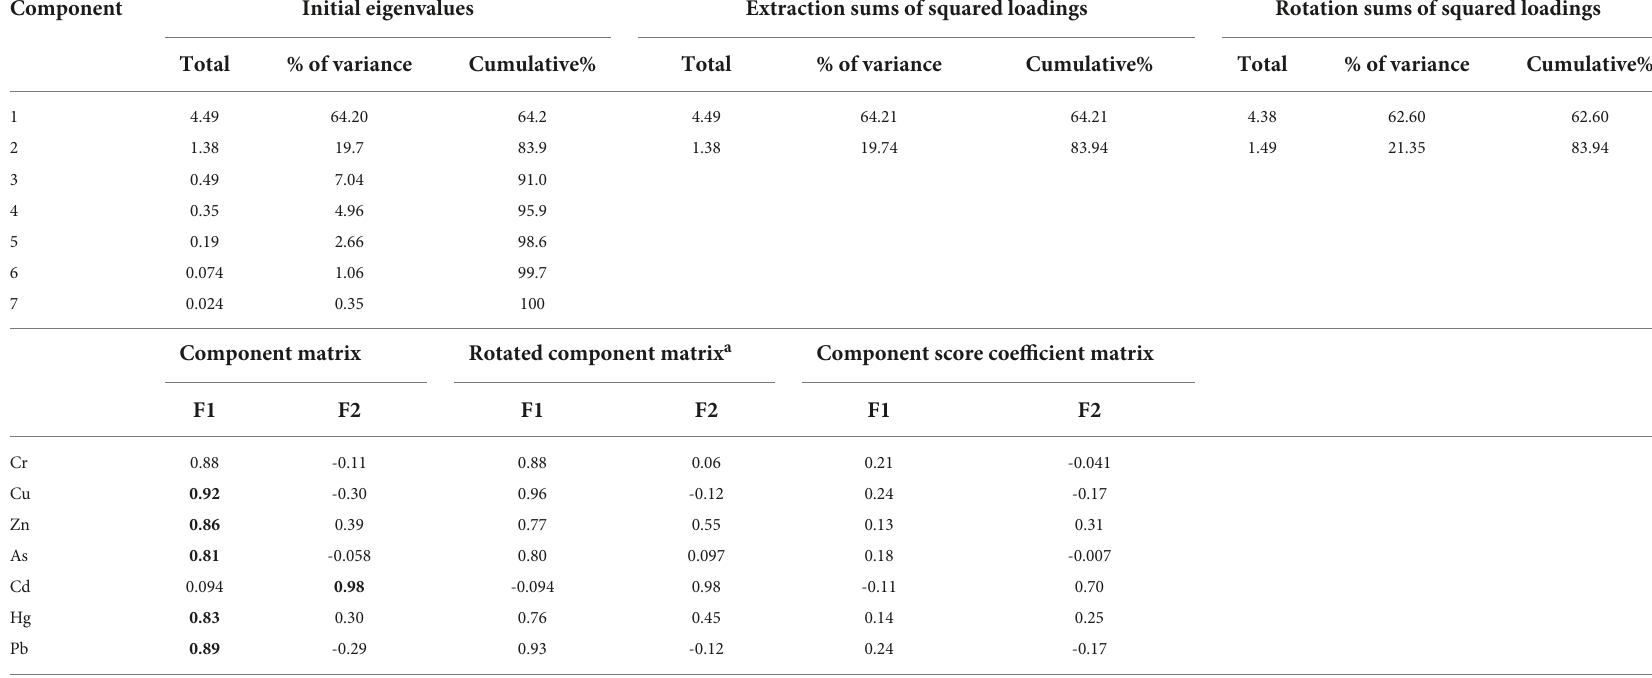
Rotation method: varimax with Kaiser normalization. The “a” marked in the upper right represents rotation converged in three iterations. The bold values represent that the correlations between the extracted principal components and the original variablesaresignificantand >